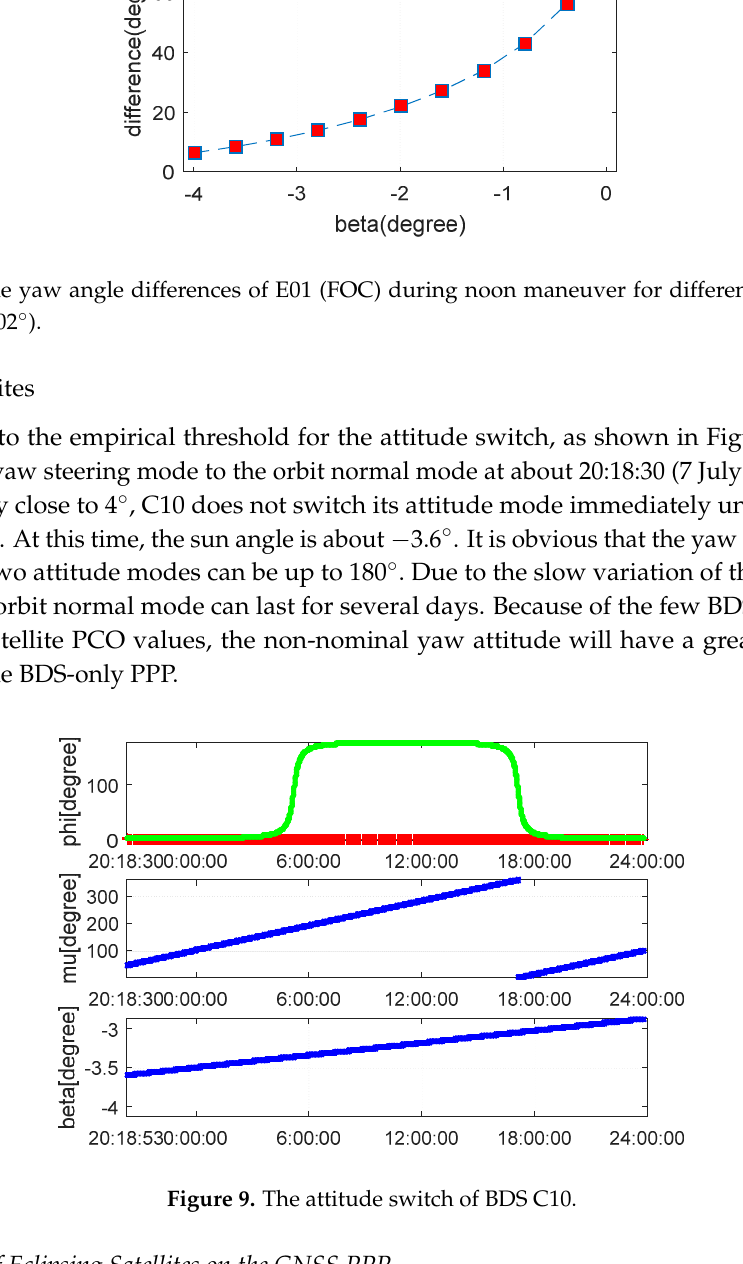
Figure 7. The yaw angle of E01 (FOC) during noon maneuver for different sun angles: ( a ) beta = − 1.99°; ( b ) beta = − 1.19°; and ( c ) beta = 0.02°. The nominal yaw angle is shown in green, while the modeled one is in red.